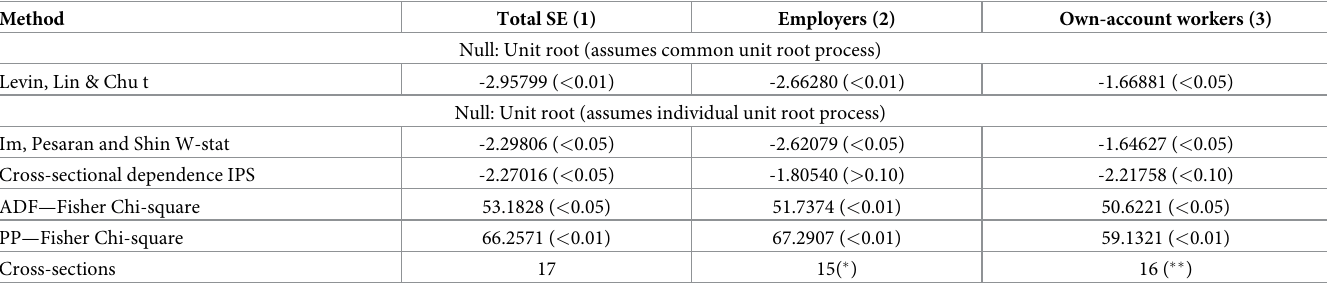
Table 1. Panel unit root test result foreign vs